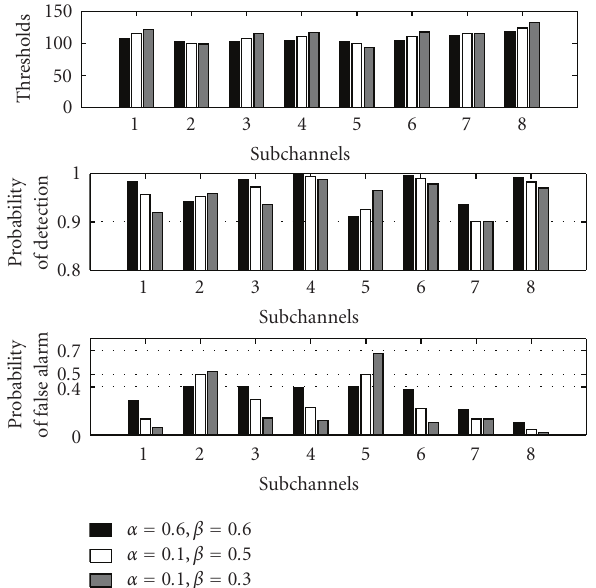
Figure 7: Optimized thresholds and probabilities of detection ( P d ) and false alarm ( P f ) on individual subbands for two of the curves in Figure 5, (cid:2) = 1 . 3. SNR = ( − 3, − 5.2, − 3.5, − 1.9, − 6, − 2.2, − 4, − 1.5).